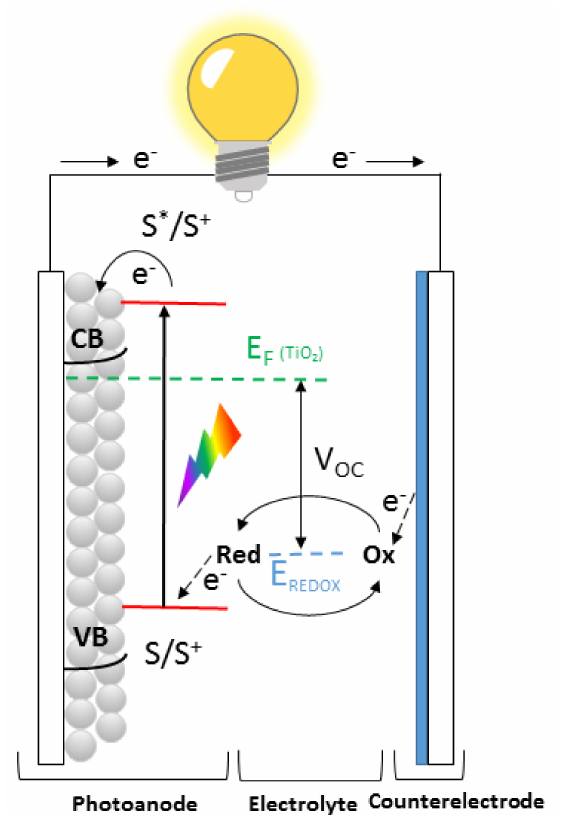
Figure 2. Schematic drawing of DSSCs based on liquid redox mediators. Transparent glass-coated transparent conductive oxides (TCO), such as fluorine doped tin oxide (FTO) or indium tin oxide (ITO), are usually employed to fabricate the charge collecting terminals of the cell, on which TiO 2 and the catalytic counter electrode layer are deposited. In solid-state (ss-DSSCs), the liquid electrolyte is replaced by the hole transport material